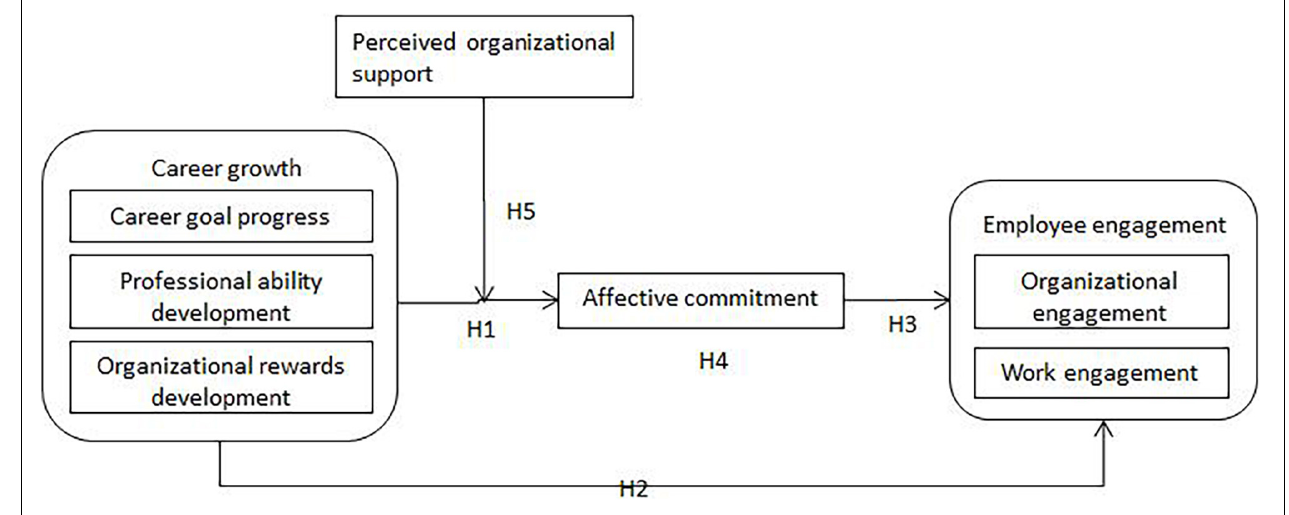
FIGURE 1 | Theoretical